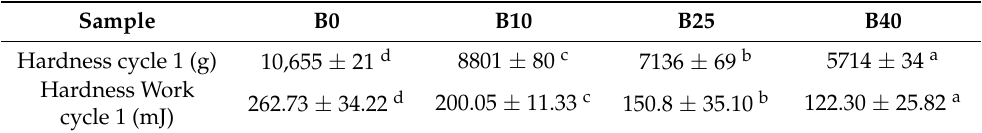
Table 8. Instrumental analysis of texture.